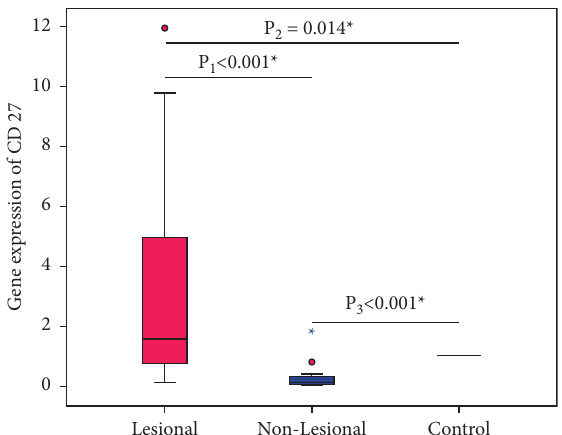
Figure 2: The relative expression of CD27 gene in patients with AA ( n � 40) compared to HCs ( n � 40). The relative CD27 gene expression in AA lesions ranged from 0.09 to 11.96 (mean 3.19 ± 3.65, median 1.58), while in non-lesional areas, it ranged from 0.0 to 1.68 (mean 0.25 ± 0.38, median 0.14). Wilcoxon signed rank test (p1) was used to compare the expression in AA lesions and non-lesional areas.